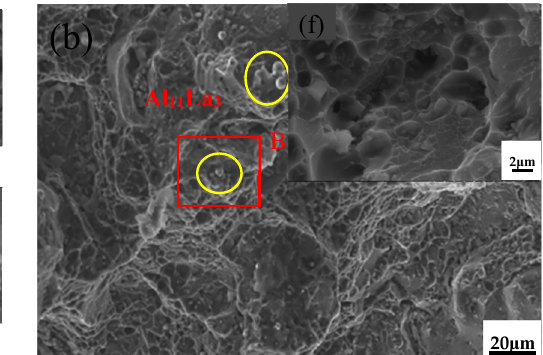
Figure 5. Mechanical properties of the alloys after T5 heat treatment.